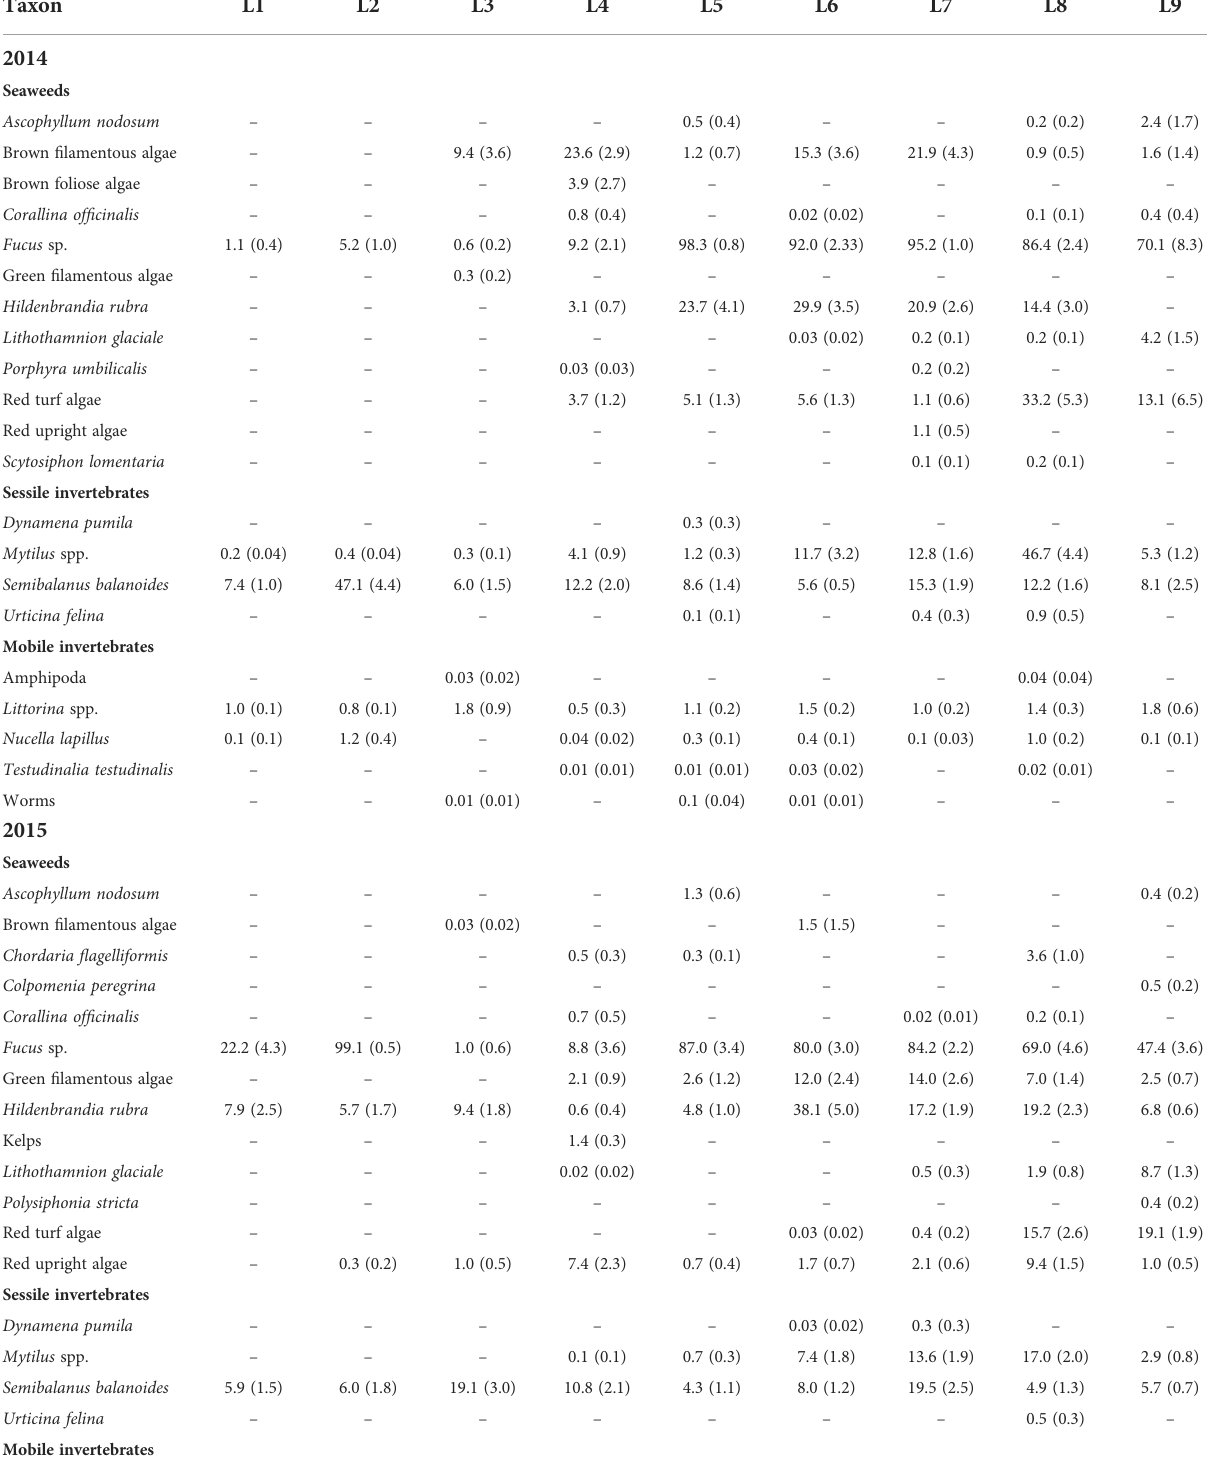
TABLE 2 Abundance of each taxon (mean with SE in parenthesis) identi fi ed at each location (L1 to L9) each studied year (2014 to 2017). The abundance of seaweeds and sessile invertebrates is expressed as percent cover, while the abundance of mobile invertebrates is expressed as density (individuals dm -2 ). See Materials and Methods for details. Values are reported to their fi rst decimal point except values lower than 0.05, which are reported to their second decimal point.